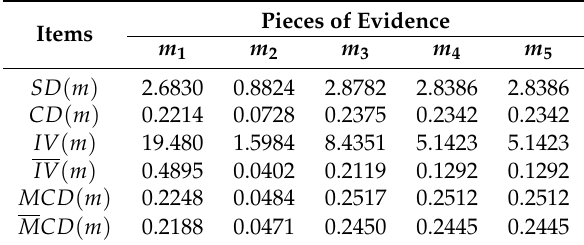
Table 2. The calculated results in terms of support degree, credibility degree, information volume, normalized information volume, credibility degree, and modified credibility degree of BPAs. Pieces of Items